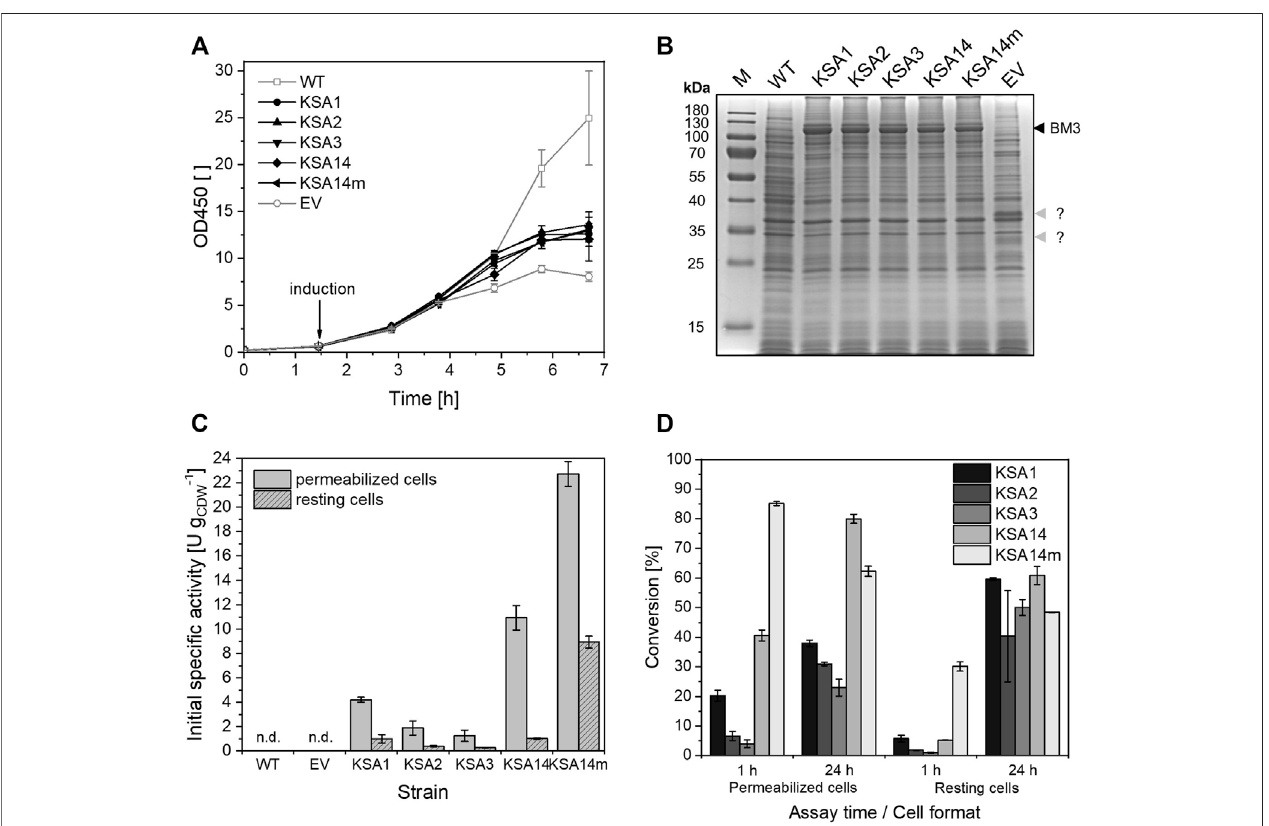
FIGURE2| Performanceof E.coli BL21-Gold(DE3)strainscarryingpETM11 withgenesencoding therespectiveBM3variants compared tothewildtype (WT)and an empty vector control (EV) strain during and after cultivation in TB medium. (A) Bacterial growth in TB medium upon induction with 0.1 mM IPTG. (B) SDS-PAGE analysis of the different strains 5 h after induction, with the band at 119 kDa representing the respective BM3 variant (black arrow). For the empty vector strain, two unidenti fi edproteins(32and38 kDa,greyarrows)wereobserved. (C) Initial(10 min)testosteronehydroxylationactivitiesofpermeabilizedandrestingcells.Activity assays were conducted as described in the Materials and Methods section. (D) Conversion of testosterone (based on product formation) by the different cell formats 1 and 24 h after substrate addition. The bars represent average values and standard deviations of two biological replicates (n.d., no product formation detected).